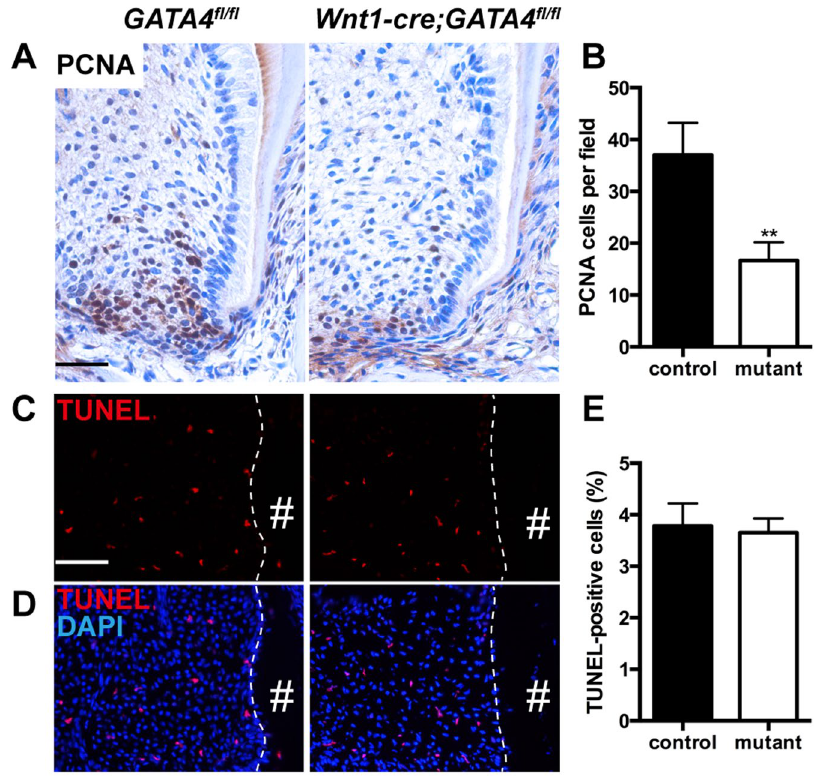
Figure 3. Changes in cell proliferation and apoptosis in the molar dental mesenchymal cells. ( A ) PCNA immunohistochemistry staining; ( B ) Percentages of PCNA-positive cells in the control and mutant groups; ( C , D ) Apoptotic cells among the mice root dental mesenchymal cells were identified by TUNEL analysis. Sections were immunostained with markers of cell death, TUNEL (red) and counterstained with DAPI (blue); ( E ) Percentages of TUNEL positive cells in control and mutant are presented (Bar: 50 μ m). # Indicates the root of mandibular molars. ** P <